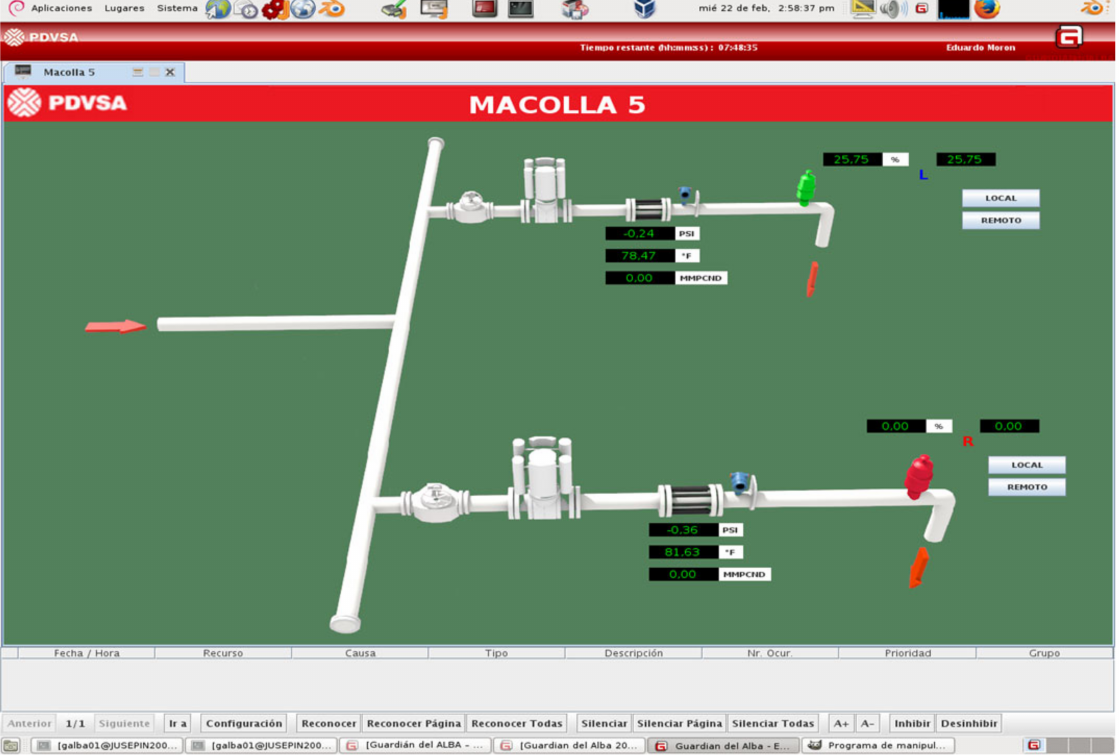
Figure 18. Display in JEDITION and the palette